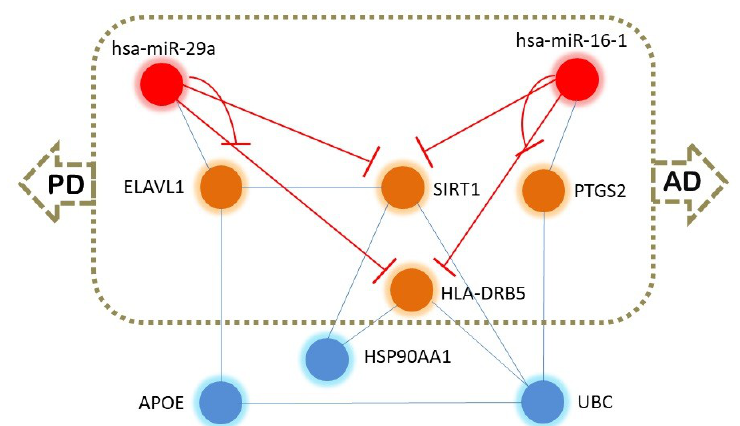
Figure 3. Epigenetic modulation of common molecules in AD and PD. The red color nodes indicate the probable common hub associated with AD and PD pathogenesis.